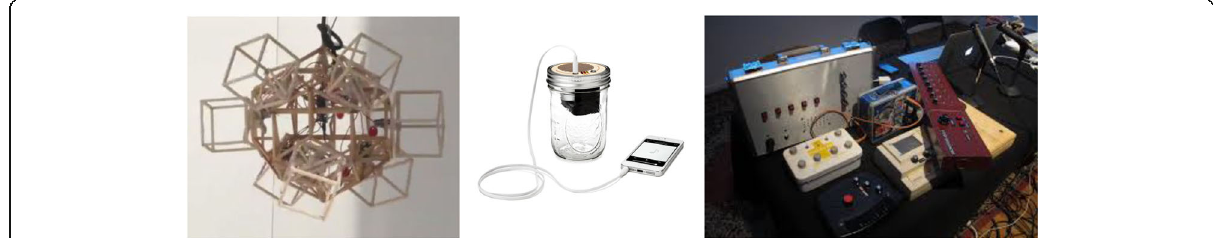
Fig. 3 Musical artifacts of the Makers (Alejandro, Cane, and Stephen, respectively)